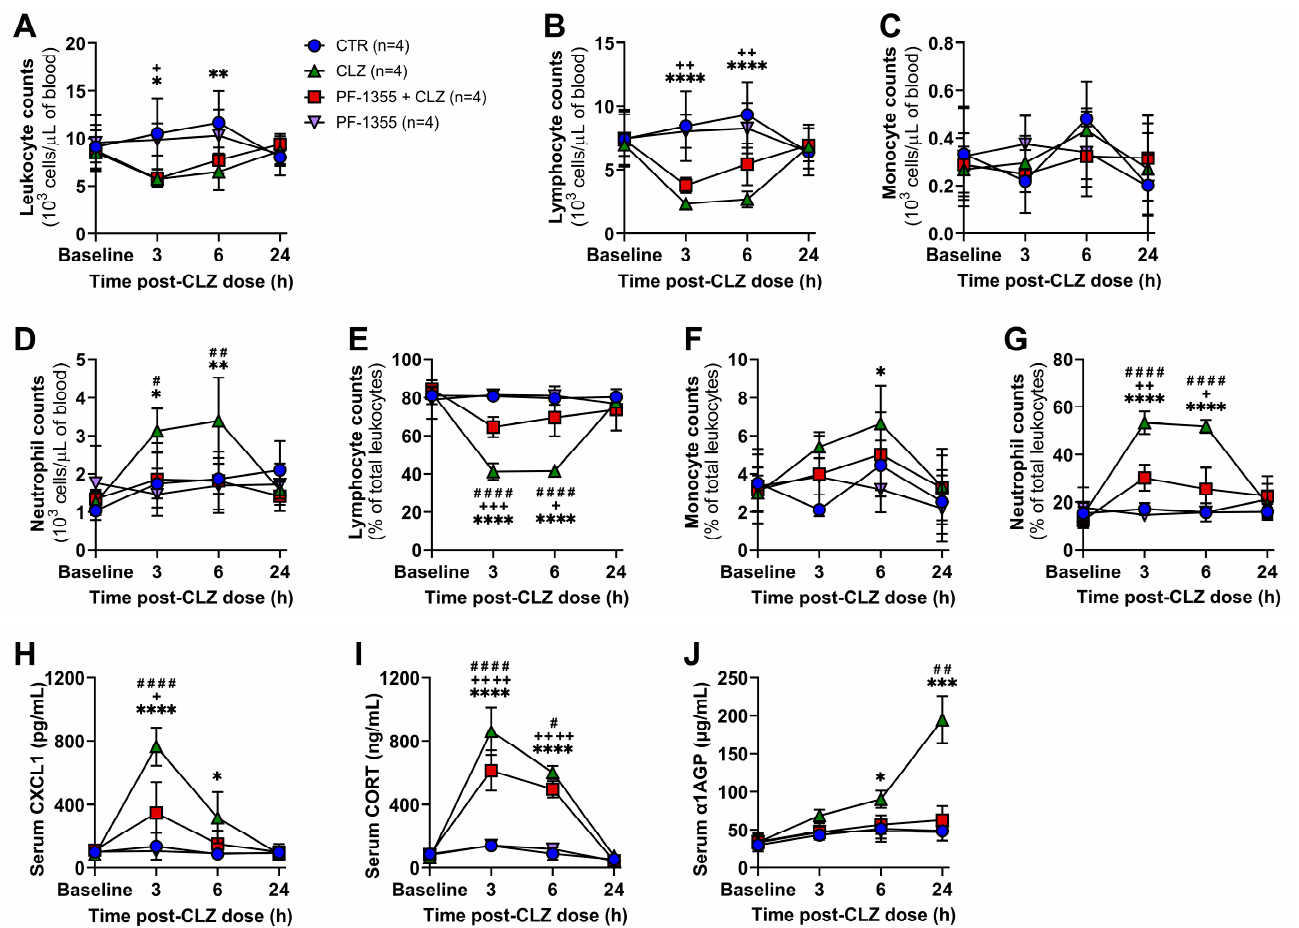
Figure 5. PF-1355 attenuates clozapine-induced increases in circulating neutrophil and inflammatory mediators in rats. ( A – D ) Absolute leukocyte ( A ), lymphocyte ( B ), monocyte ( C ), and neutrophil ( D ) counts, presented as 10 3 cells/ µ L of blood, in female Sprague Dawley rats over 24 h following treatment with vehicle controls, PF-1355 (100 mg/kg, PO), clozapine (30 mg/kg, IP), or PF-1355 and clozapine. ( E – G ) Corresponding lymphocyte ( E ), monocyte ( F ), and neutrophil ( G ) counts, presented as a percentage of total leukocytes. Differential blood counts were determined using a VetScan HM5. ( H – J ) Serum concentrations of CXCL1 ( H ), corticosterone ( I ), and α 1AGP ( J ) over 24